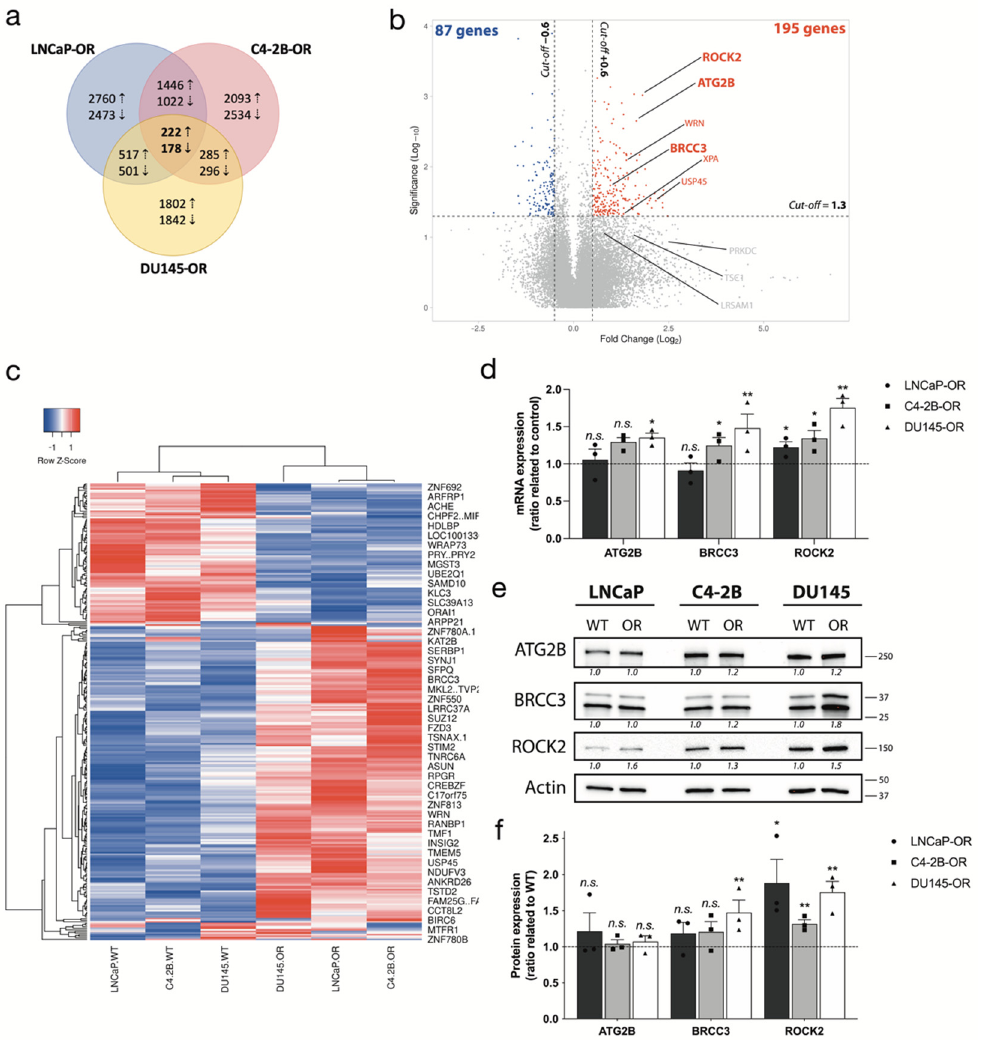
Figure 3. Determination of the most upregulated and downregulated genes in all three PC-OR cell lines. ( a ) Venn diagram representing all genes that were upregulated (222) and downregulated (178) in all OR cell lines compared to all WT cell lines. ( b ) Volcano plot with fold change(log2) ≤ − 0.6 and with a fold change(log2) ≥ +0.6 as thresholds for gene expression, and (log − 10) q -value ≥ 1.3 as the threshold for statistically significant variation of expression. A total of 195 upregulated (red) and 87 downregulated (blue) genes were identified using these thresholds. ( c ) Heatmap showing all significantly upregulated genes in red and all significantly downregulated genes in blue. ( d ) Validation of ATG2B, BRCC3 and ROCK2 RNA expression by RT-qPCR. ( e ) Validation of ATG2B, BRCC3 and ROCK2 protein expression by Western blot. Actin was used as loading control. ( f ) Quantitation of ( e ). For all data, the mean ± SEM of three independent experiments is shown. Data were analyzed using the two-tail Student t -test. n.s. = non-significant. * p < 0.05 and ** p <